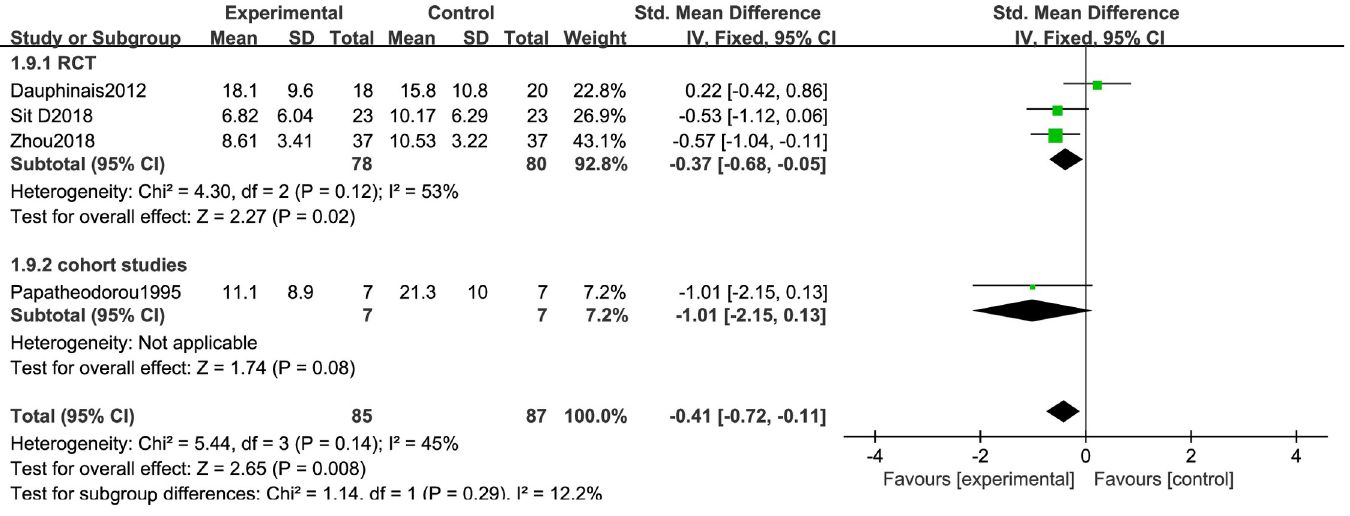
Fig 3. Forest plots with phototherapy greater than